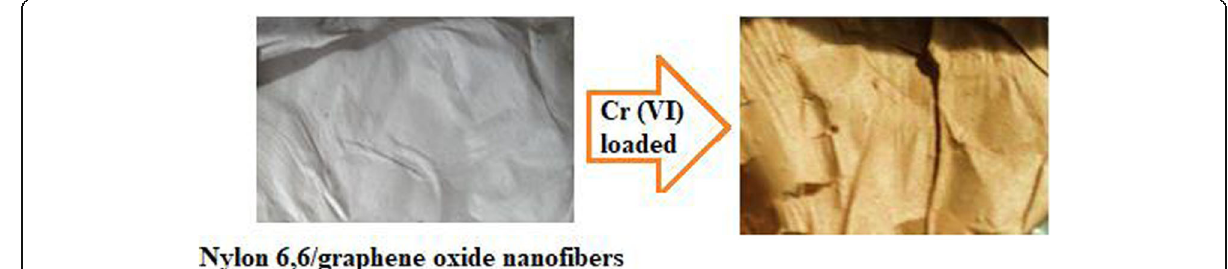
Fig. 7 Image of Nylon 6,6/graphene oxide nanofibers before and after Cr (VI)